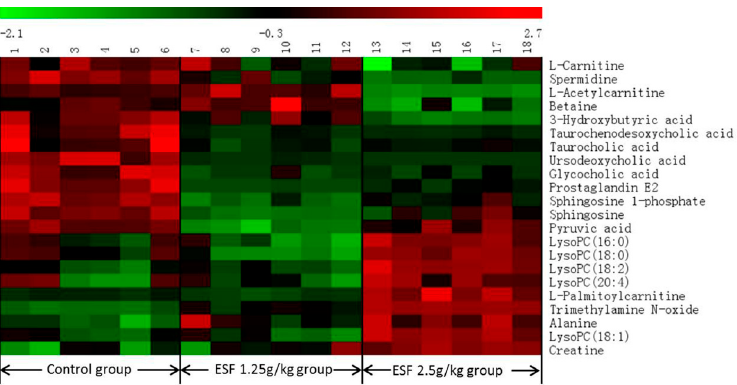
Figure 5. The heat map denoting fold changes of the 22 differential metabolites in different groups of rats dosed with extract of Sophora flavescens for two weeks.